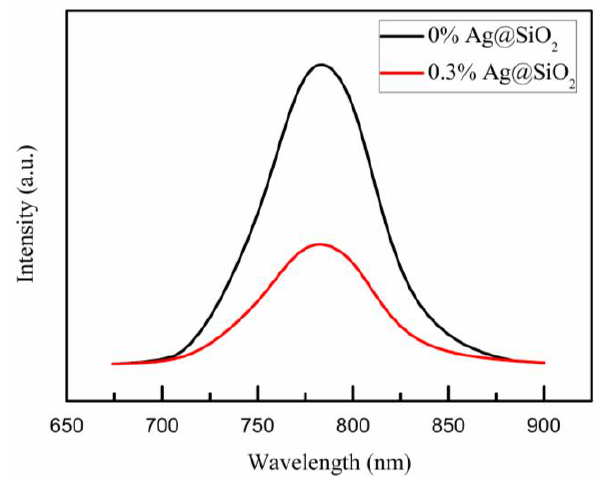
Figure 9. PL spectra of compact TiO 2 /Ag@SiO 2 -TiO 2 /ZrO 2 /perovskite films at room temperature of 296 K.